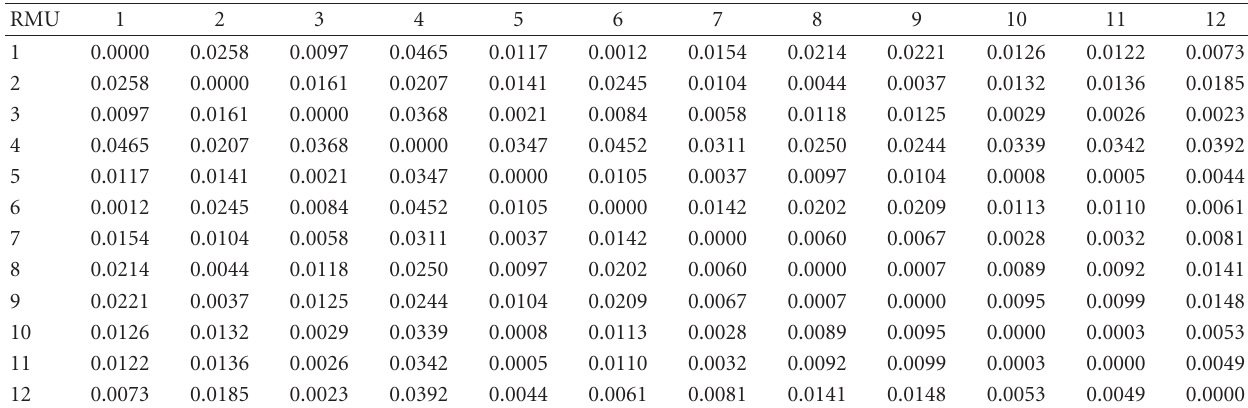
Table 7: The distance between any two RMUs.